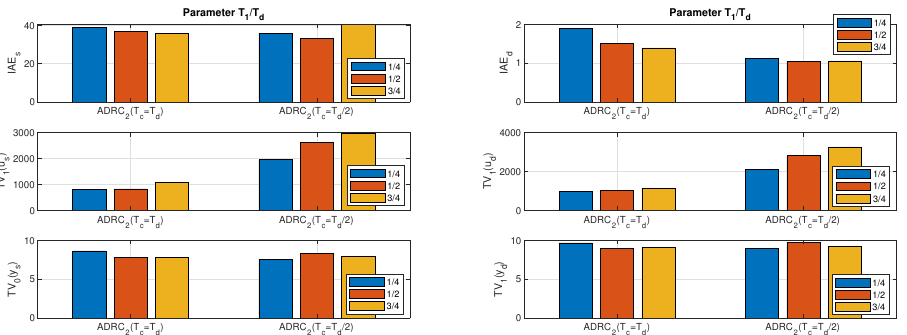
Figure 8. ADRC 2 : Performance measures corresponding to the controller in Figure 3 and transients in Figure 7, T dm = T d = T d − T 1